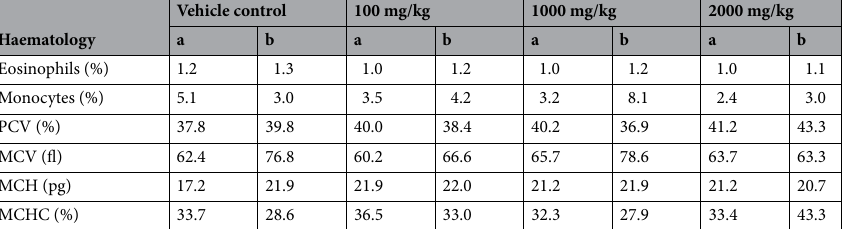
Table 1. Analyses of blood parameters after 14 days of oral administration of Disarib in Wistar rats. Blood parameter analysis was done after 14 days of Disarib administration (0, 100, 1000, 2000 mg/kg b. wt.) by oral route. ‘a’ and ‘b’ are indicative of two different animals of the same group used for the study. PCV packed cell volume, MCV mean cell volume, MCH mean corpuscular haemoglobin, MCHC mean corpuscular haemoglobin